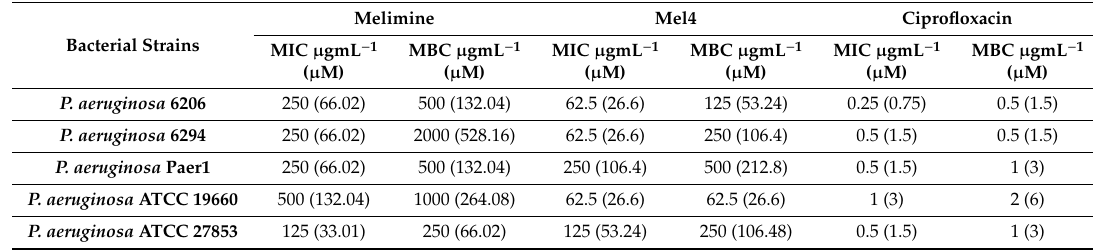
Table 1. MIC and MBC of melimine, Mel4 and ciprofloxacin against P. aeruginosa. Bacterial